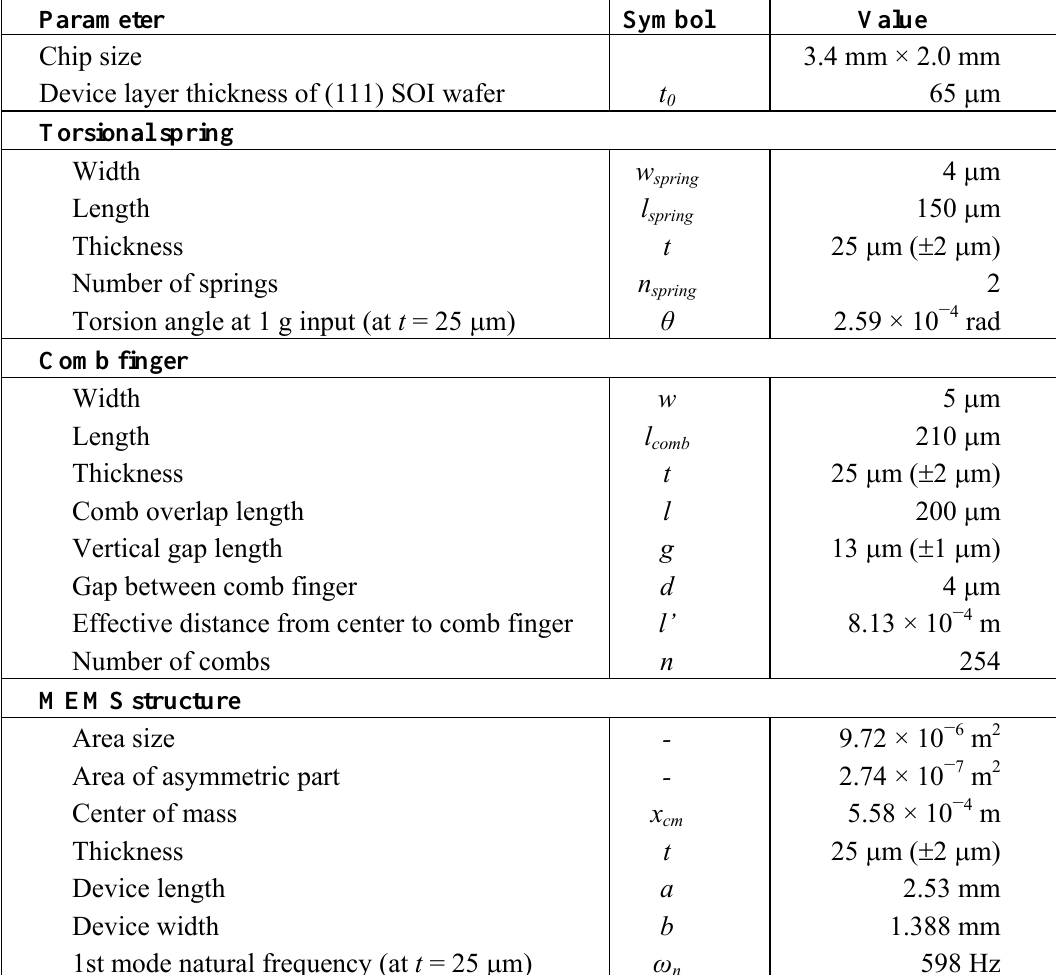
Table 1. Summarized design parameters of the MEMS sensing